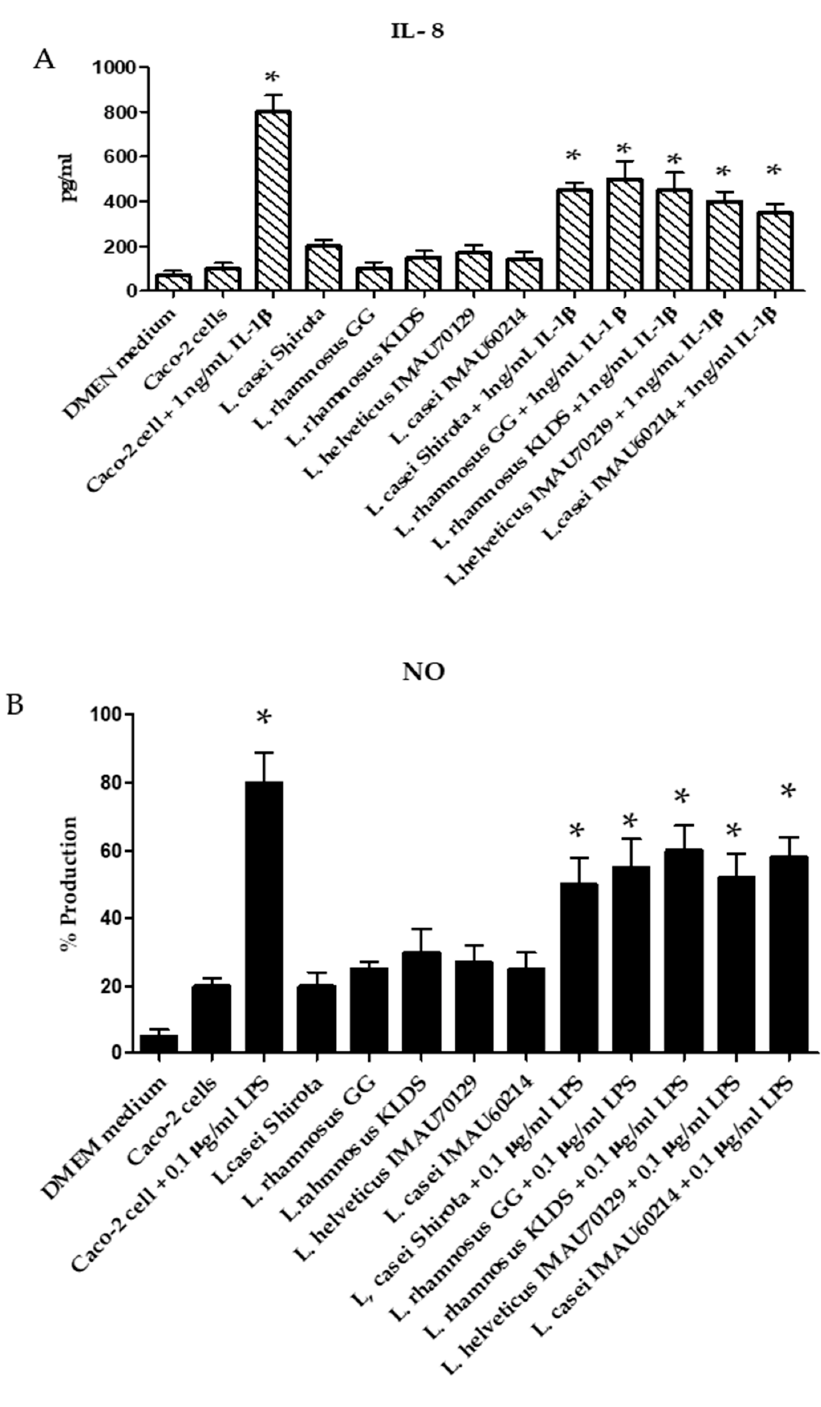
Figure 7. Immunomodulatory activity of Lactobacillus strains on the secretion of interleukin-8 (IL)-8 and NO on Caco-2 cells. ( A ) Baseline IL-8 response and production in an IL-1 β (1 ng/mL) stimulated inflammatory environment. ( B ) Nitric oxide production at baseline and under an inflammatory environment stimulated with LPS (0.1 µ g/mL). Values represent the mean ± SD ( n = 3). * significant differences among Lactobacillus strains ( p <